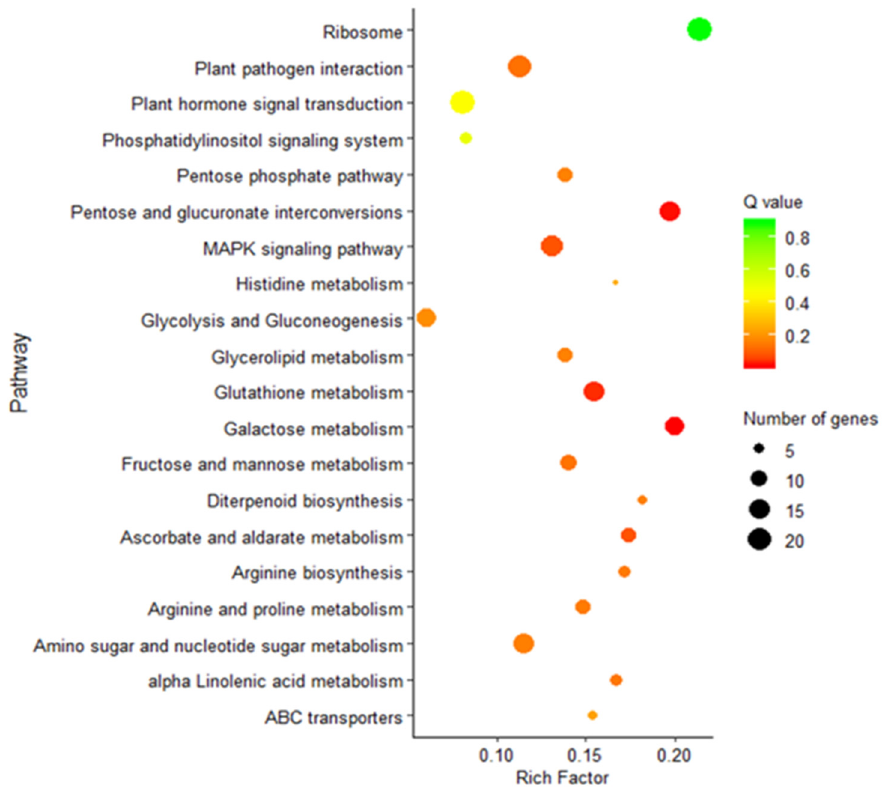
Figure 3. KEGG pathway analysis of DEGs. Advanced bubble chart shows enrichment of DEGs in signaling pathways. Y-axis label represents pathways, and the X-axis label represents the rich factor. Size of the bubble represents the amount of DEGs enriched, and the colour shows the enrichment means in pathways.